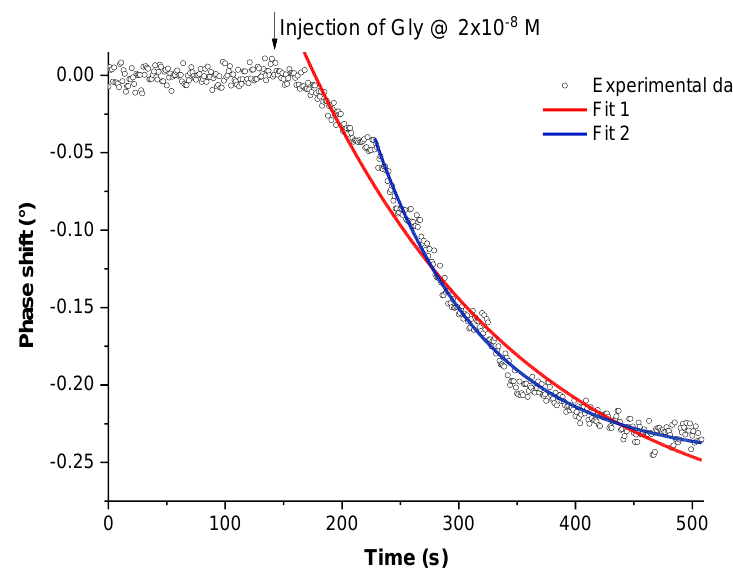
Figure 5. Phase shift versus time variations of the MIP-SAW sensor after the injection of a Gly solution 2 × 10 −8 M. Experimental results in black dots; exponential decay fit considering the entire recognition time: fit1 in red solid line; and exponential decay fit considering a restricted time domain: fit 2 in blue solid line.